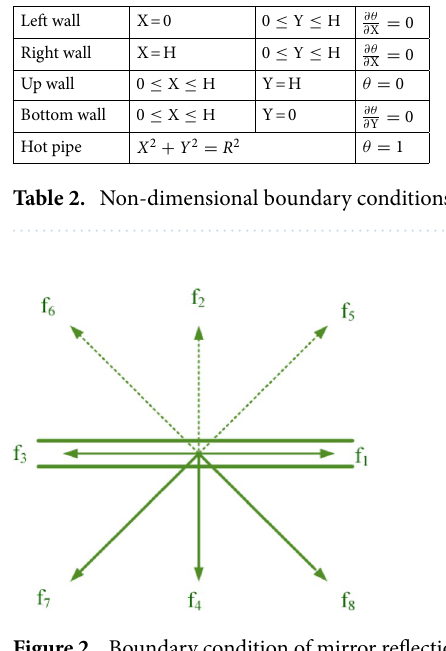
Figure 2. Boundary condition of mirror